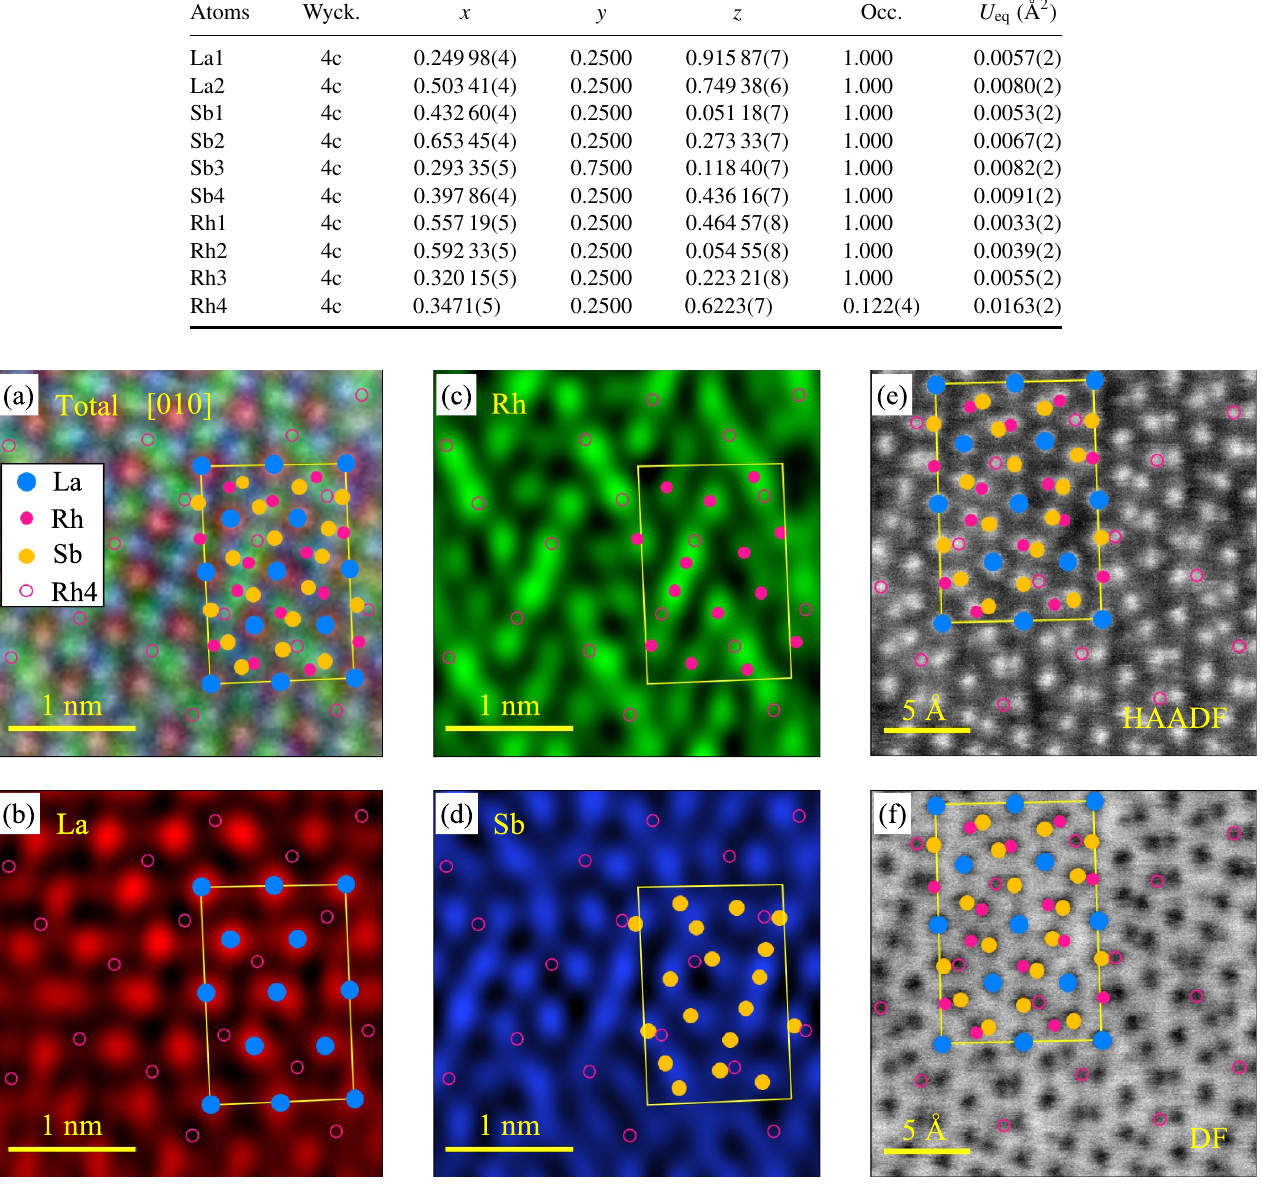
Figure 2. STEM images of La 2 Rh 3 + δ Sb 4 on [0 1 0] plane. STEM-EDS elemental maps respectively for (a) total, (b) La, (c) Rh, and (d) Sb. The atomic coordinates in a unit cell of La 2 Rh 3 + δ Sb 4 are projected to the images. The filled blue, pink and green circles are La, Rh(1–3) and Sb atoms, respectively, while the open pink circles represent the occupied Rh4 sites. (e) HAADF image. (f) DF